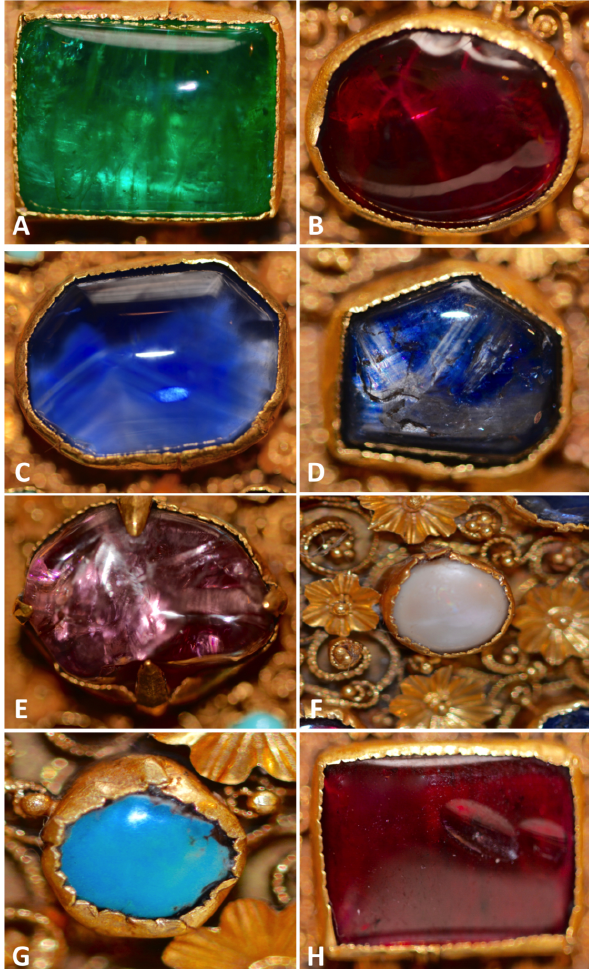
Figure 2. Detailed pictures of the gems set in the reliquary crown of Namur (© Frédéric Hatert). (a) Rectangular emerald p5-1. (b) Rounded red garnet p6-2. (c) Sapphire with a growth structure p1-4. (d) Sapphire with oriented rutile inclusions producing a par- tial asterism p3-2. (e) Reddish pink spinel p1-3. (f) Round pearl be- tween sapphire p8-1 and spinel p8-3. (g) Turquoise on the p1 gold plate. (h) Rectangular garnet with two traces of removed inclusions